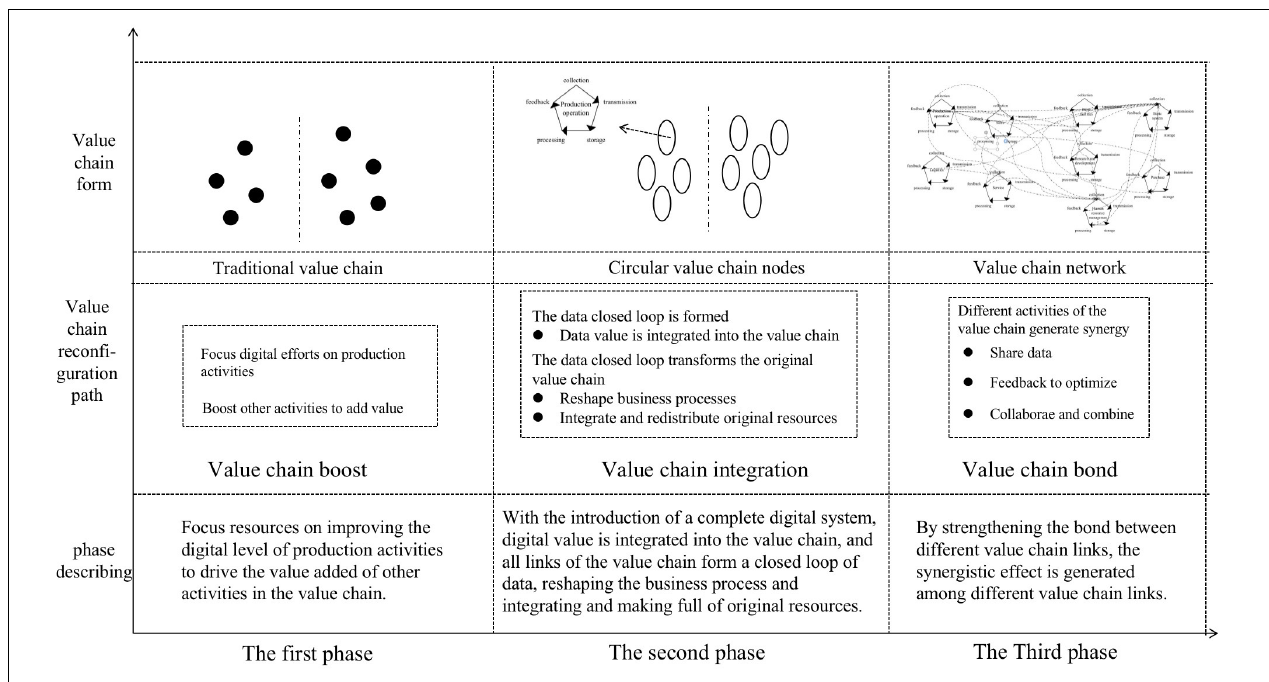
FIGURE 4 | Process model of value chain